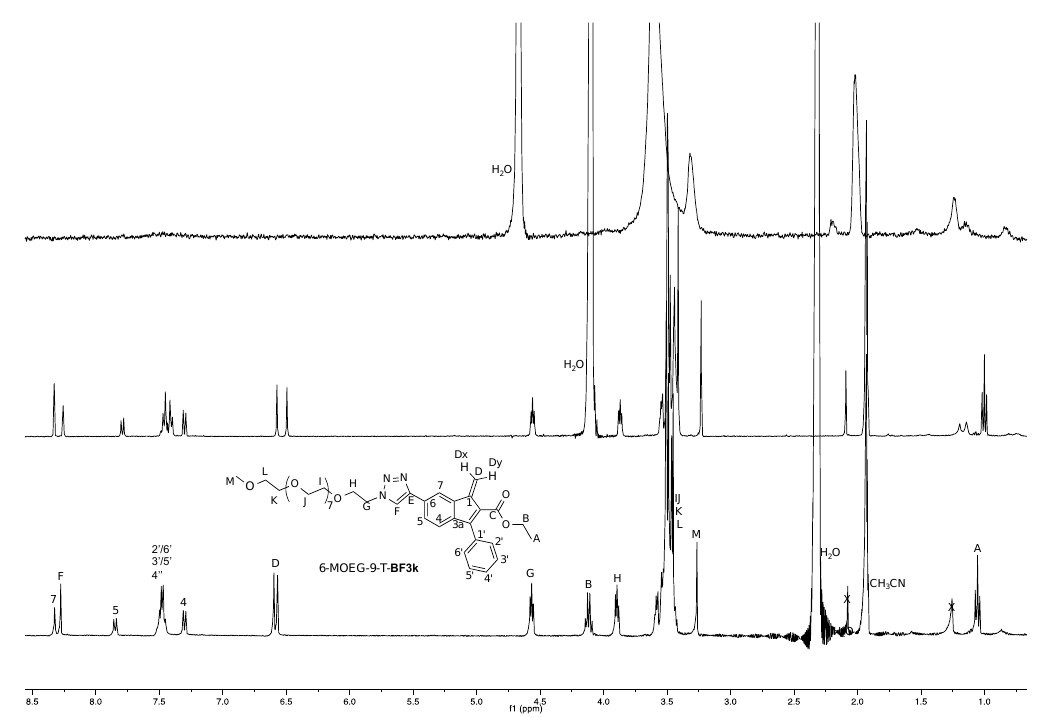
Figure 6. 1 H NMR spectra performed during the transferring of the benzofulvene monomer 6-MOEG-9-T- BF3k in the water environment. Comparison of 1 H NMR spectrum of the benzofulvene monomer in CD 3 CN (bottom trace) with that of the same monomer after diluting (1:1) with D 2 O (middle trace) the initial monomer solution and after the partial evaporation of the organic solvent (top trace).